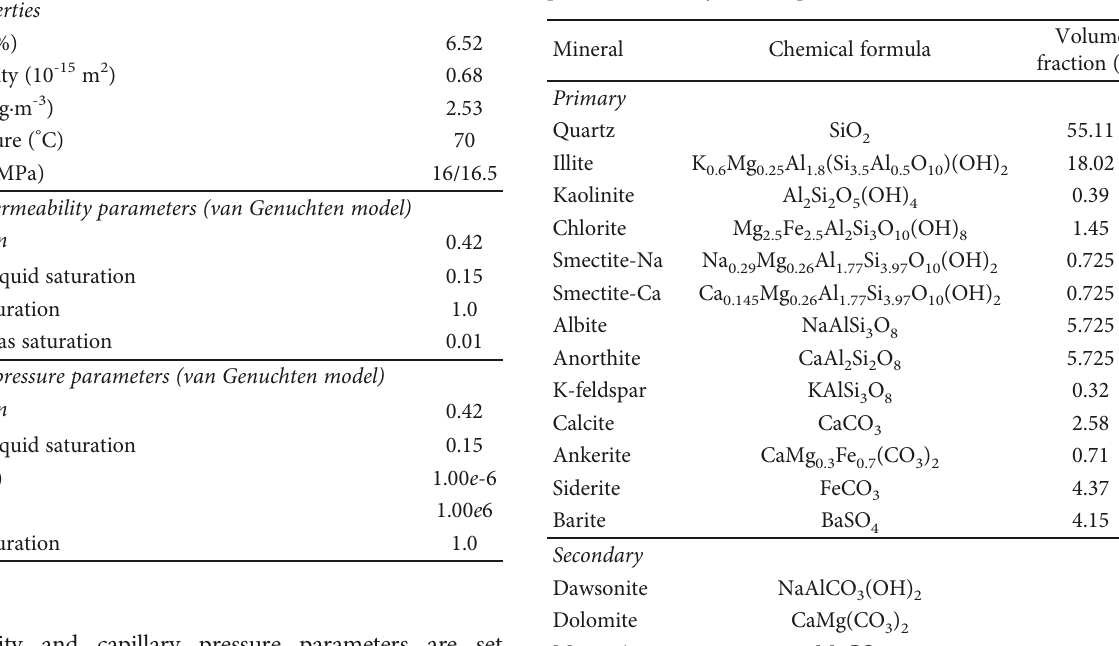
Table 2: Physical parameters for the Longtan sandstone Formation. Table 3: Initial mineral volume fractions in the sandstone and possible secondary mineral phases in the simulation.